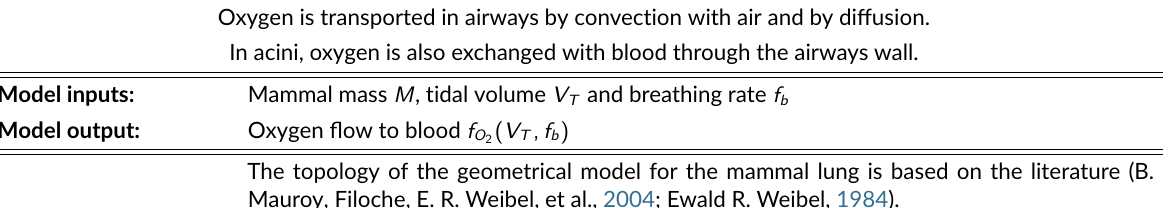
Table 6 – Hypotheses of the model 2 that simulates the transport of oxygen in the lung. Model 2: Oxygen transport in the lung , adapted from Noël and Benjamin Mauroy (2019) Oxygen is transported in airways by convection with air and by